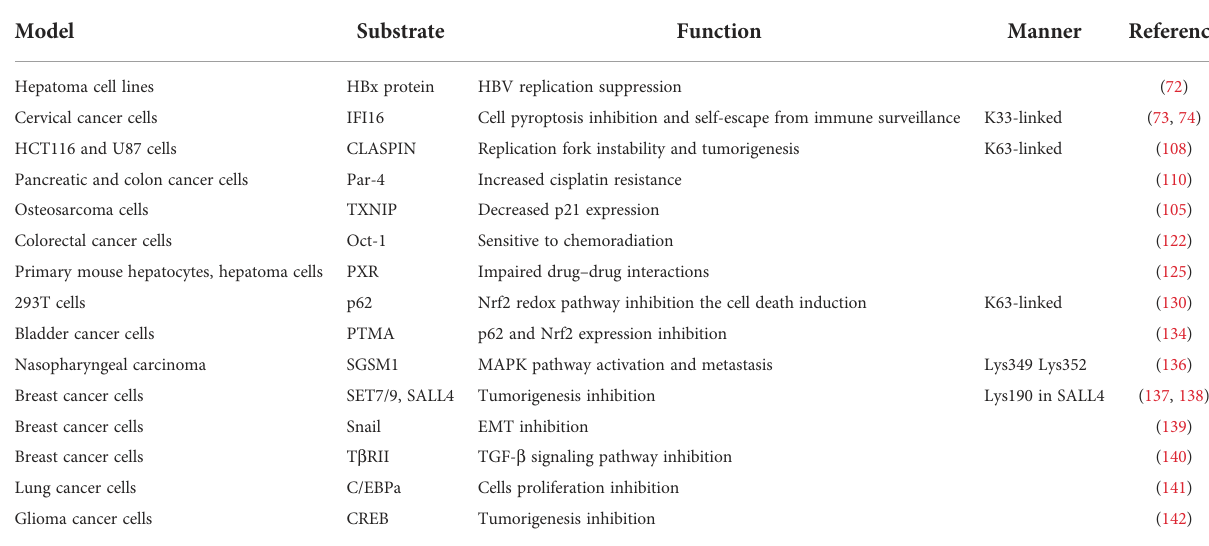
TABLE 1 Substrates of TRIM21 involved in cancer